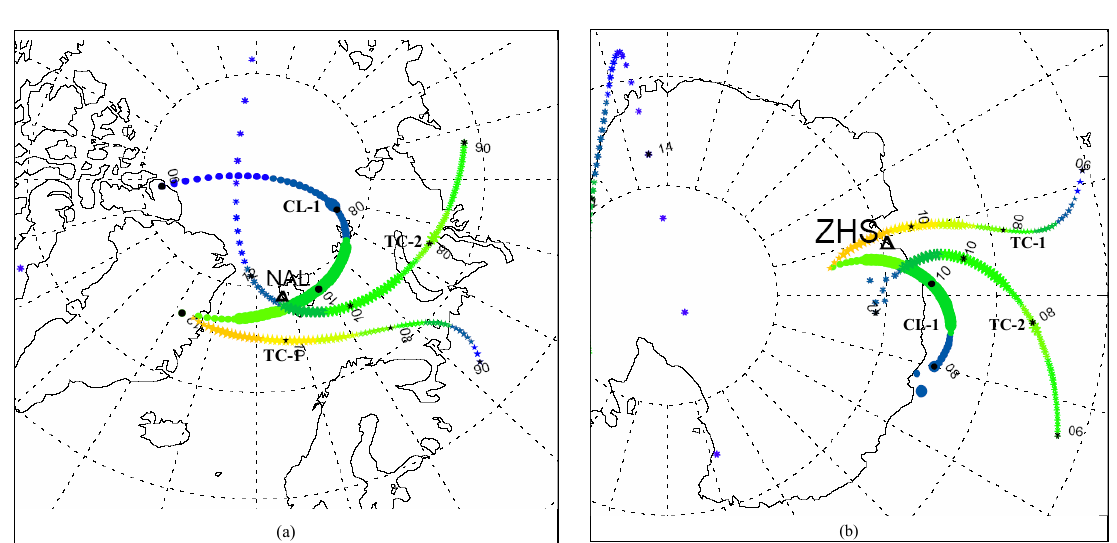
Locations of the footprints of TC-1, TC-2 and CL-1 spacecraft in (a) the northern hemisphere and (b) the southern hemisphere, respectively, during 06:00-18:00UT on 25 Feb. 2005.